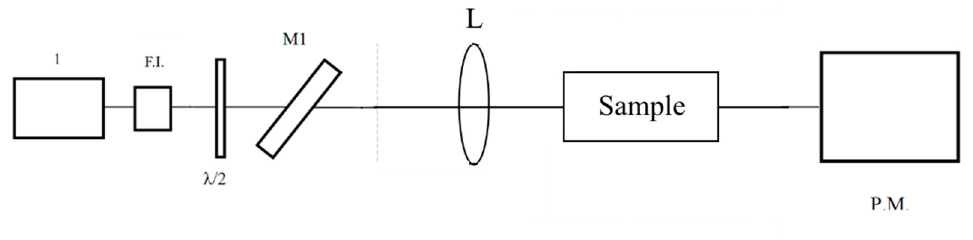
Figure 6. Optical schematic layout of the experimental setup: 1 is the Ho:YAG laser, F.I. is the Faraday isolator, λ /2 is the half-wave plate, M1 is the polarizing mirror, L is the lens, P.M. is the Ophir power meter.